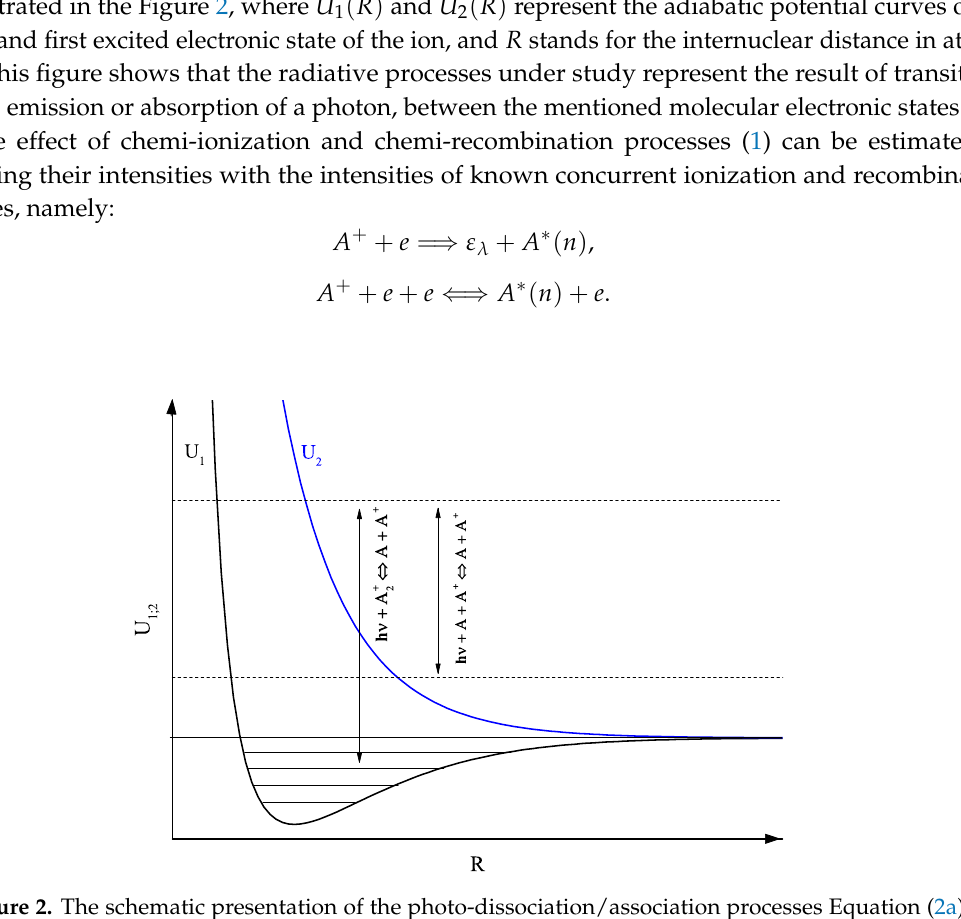
, and h ν is the 2